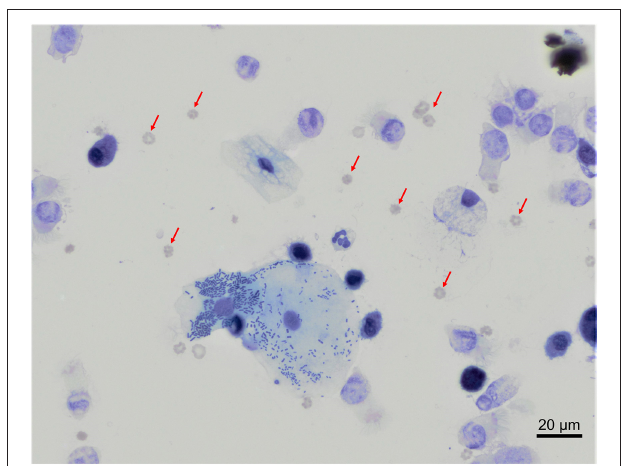
FIGURE 4 | Mixed contaminations of a bronchoalveolar lavage from a healthy cynomolgus macaque. Several erythrocytes (red arrows) are present on the background. In the center, a large squamous epithelial cell exhibits multiple rode-shaped bacteria on its surface. Modified Giemsa. X50 objective. Oil immersion.